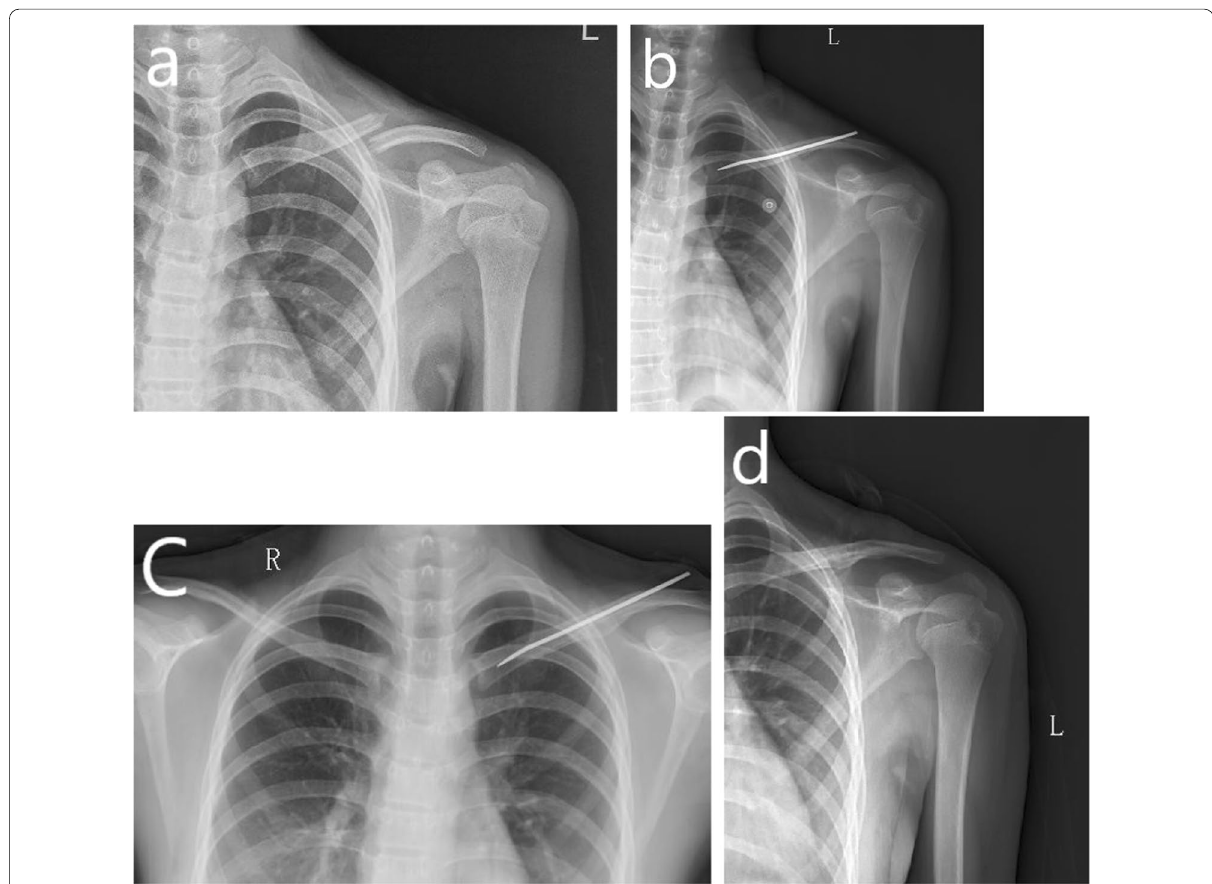
Fig. 1 Ten-year-old boy with a right clavicle fracture treated with an ESIN. a AP view of the right clavicle before surgery. b AP view of the right clavicle after surgery. c AP view of the right clavicle at the 1-month follow-up visit after surgery. d AP view of the right clavicle after hardware removal. e AP view of the right clavicle at the 2-month follow-up visit after hardware removal. AP Anterior